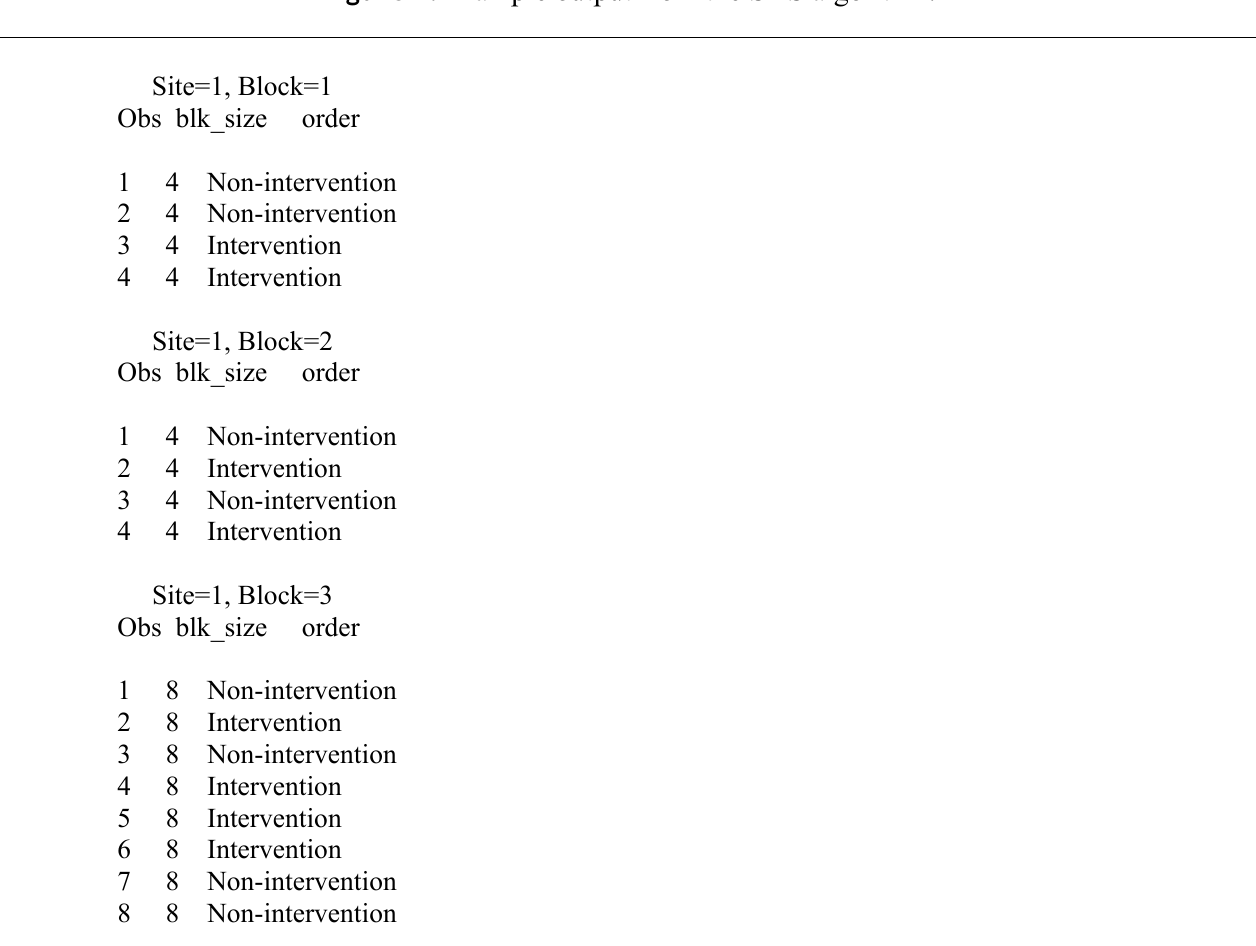
Figure 2. Example output from the SAS